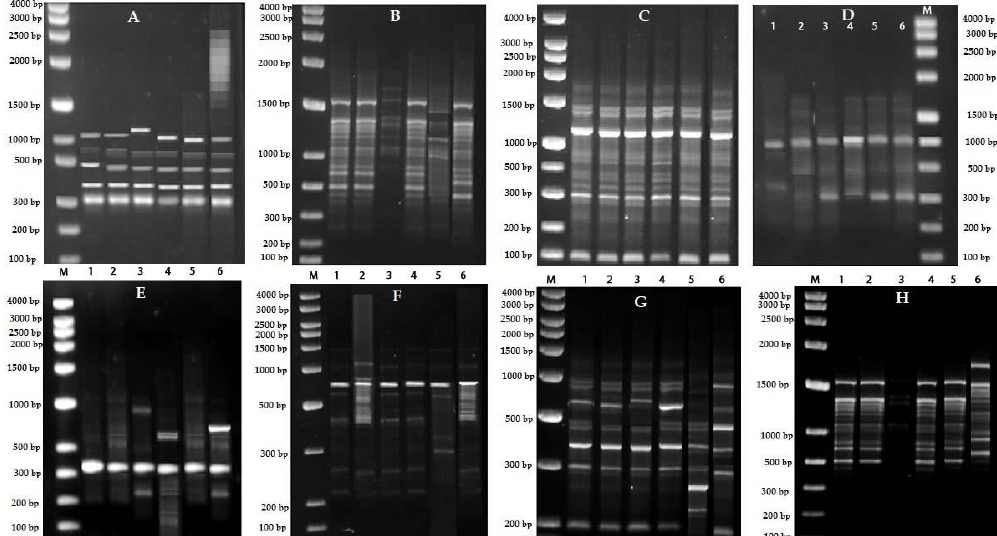
Figure 2. RAPD profile of V. serpens with ( A ) OPAA-01, ( B ) OPAA-03, ( C ) OPAA-04, ( D ) OPAA-07, ( E ) OPAA-08, ( F ) OPAA-09, ( G ) OPAA-10, and ( H ) BG-02 primers. Lane M = DNA ladder. Lanes 1–6 are accessions of V. serpens.